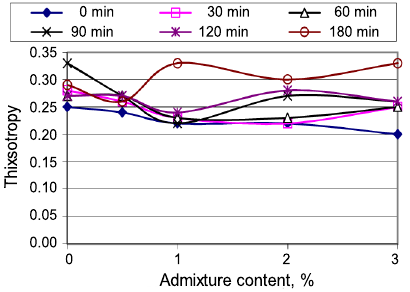
Fig. 17. Thixotropy of cement paste with CEM II R cement